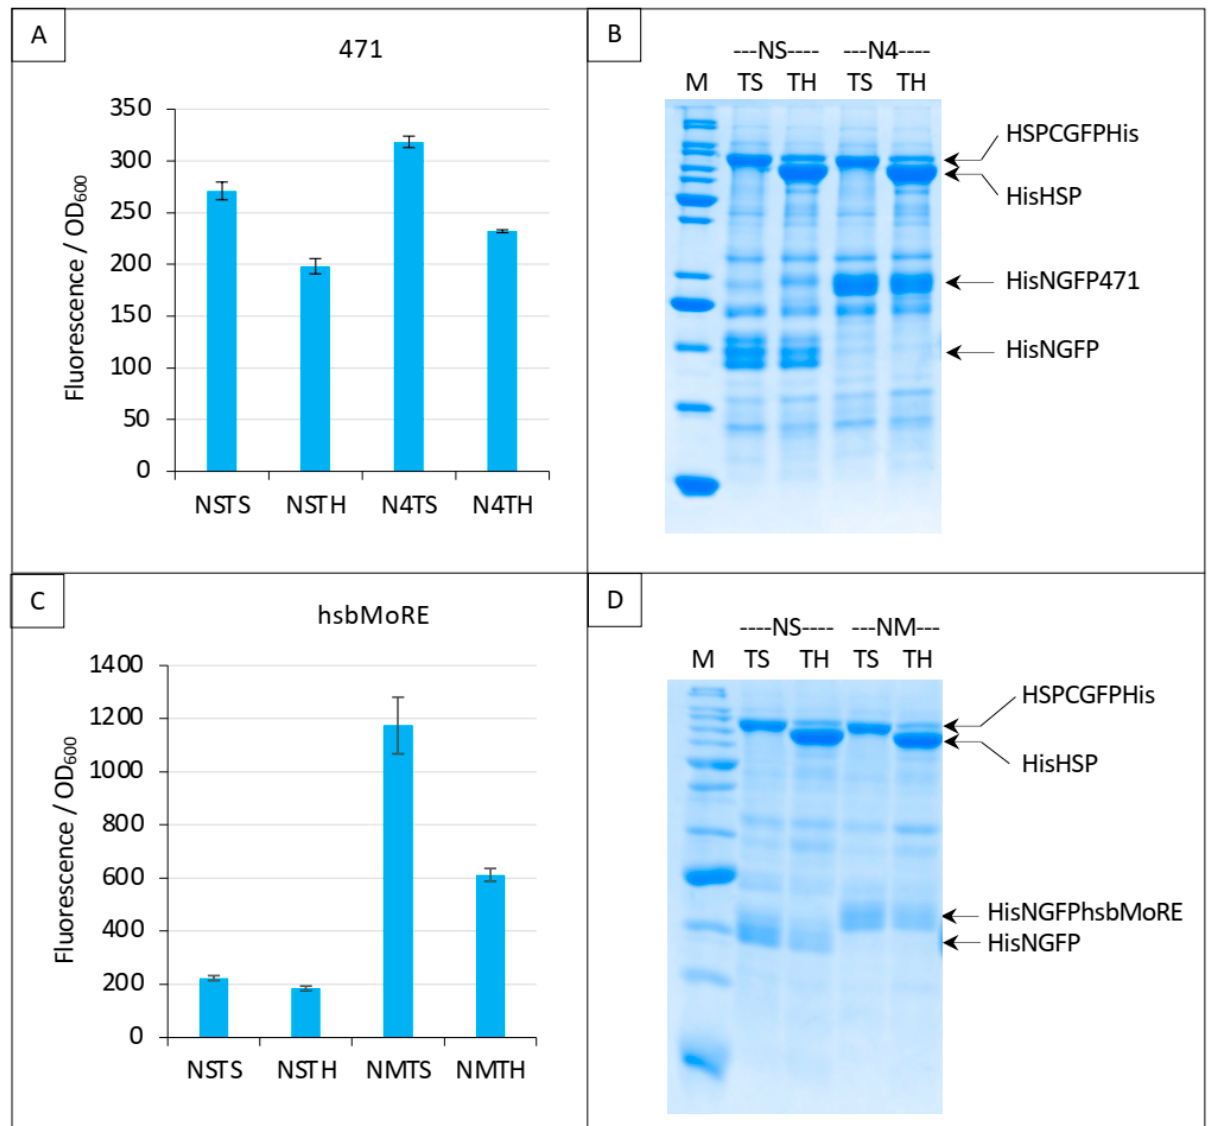
Figure 9. Split-GFP reassembly competition assay using NGFP-471 ( A , B ) or NGFP-hsbMoRE ( C , D ) with HSP-CGFP, and HSP as competitor. ( A , C ) Fluorescence data. ( B , D ) SDS-PAGE analysis of protein expression. See main text for a description of NSTS, NSTH, N4TS and N4TH. M, molecular mass markers (200, 150, 100, 85, 60, 50, 40, 30, 25, 20, 15, 10 kDa).